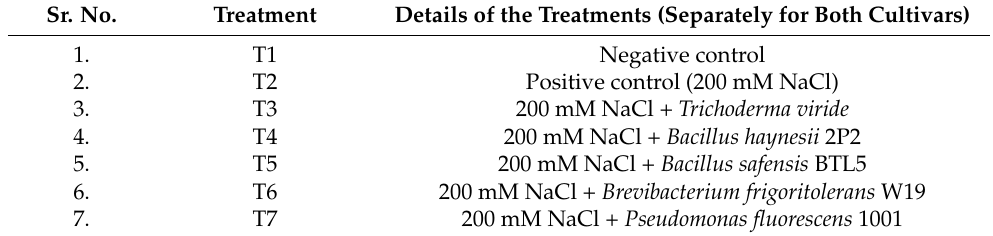
Table 4. Treatment details used for the pot trial. Sr. No. Treatment Details of the Treatments (Separately for Both